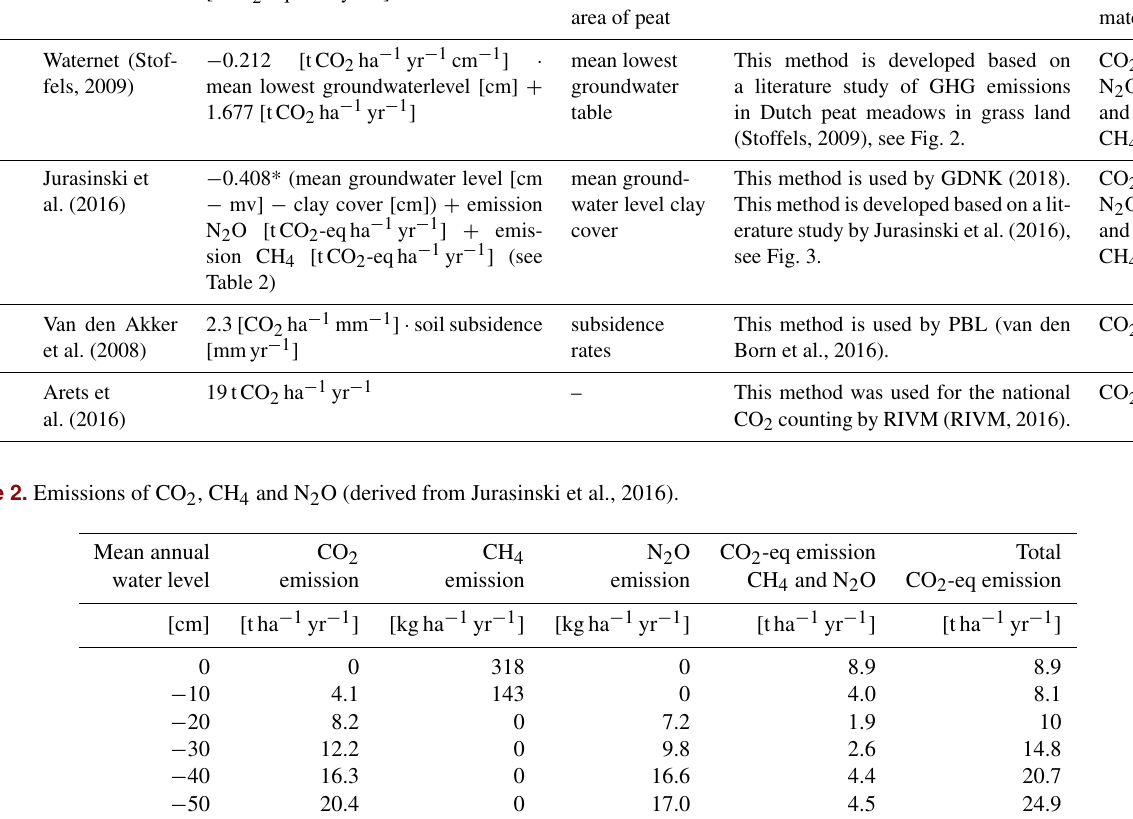
esti- mated CO 2 , N 2 O and CH 4 CO 2 CO 2